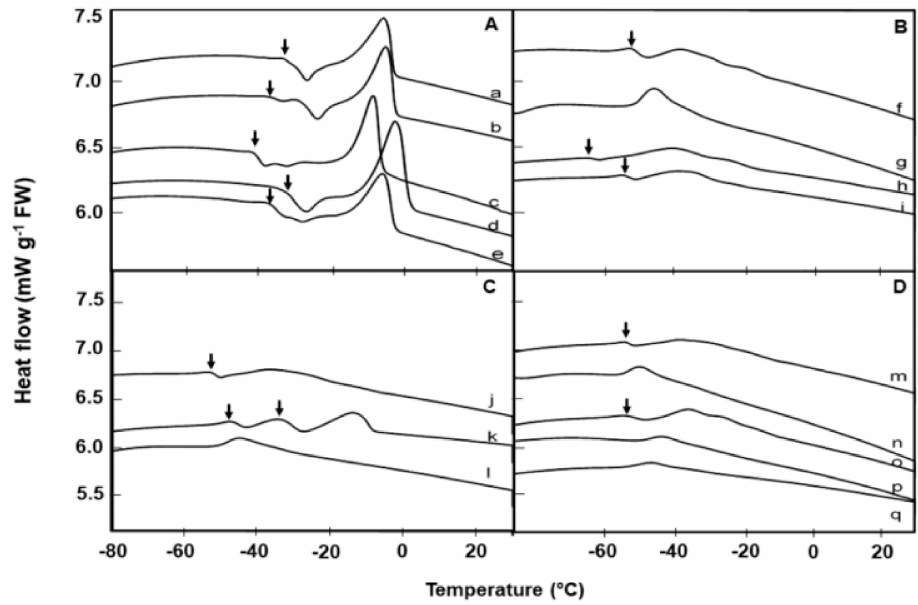
Figure 1. Comparative warming thermograms (at 10 ◦ C min − 1 ) of lipid thermal transition events in seeds of 17 Brassicaceae species from UPM collection, measured using di ff erential scanning calorimetry. Lipid crystallization ( ↓ ) events during warming, prior to the main melting transitions are evident in 12 species. A: Species with high lipid melt enthalpy: Barbarea intermedia (a), Erucastrum abyssinicum (b), Conringia orientalis (c), Brassica napus (d), and Sinapis arvensis (e). B: Species with medium lipid melt enthalpy: Coincya rupestris (f), Matthiola sinuata (g), Descurainia sophia (h), Erysimum odoratum (i). C: Species with medium lipid melt enthalpy: Erysimum repandum (j), Erysimum cheiri (k), Alyssum saxatile (l). D: Species with low lipid melt enthalpy: Sisymbrium orientale (m), Arabis turrita (n), Moricandia arvensis (o), Matthiola incana (p), Alyssoides utriculata